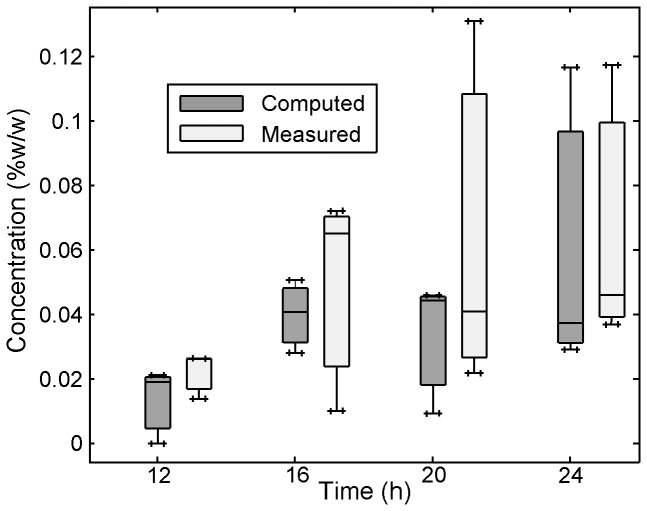
Tenofovir concentrations (measured vs. computed) in the bottom fluid compartment in the Transwell assay.A mass balance computation calculated the difference between the initial amount of Tenofovir in the fluid overlayer and the subsequent time-dependent sum of the total amounts of drug in the top layer and tissue. The good agreement between this mass balance prediction and the actual values measured supports the accuracy of the measurements. The box-and-whisker plot shows smallest value (lower bar), lower quartile (bottom of box), median (line through box), upper quartile (top of box), and largest observation (upper bar). The concentrations in the bottom fluid compartment from 0 to 9 h were not measurable (i.e., they were below the lower detection limit of the Raman quantification).